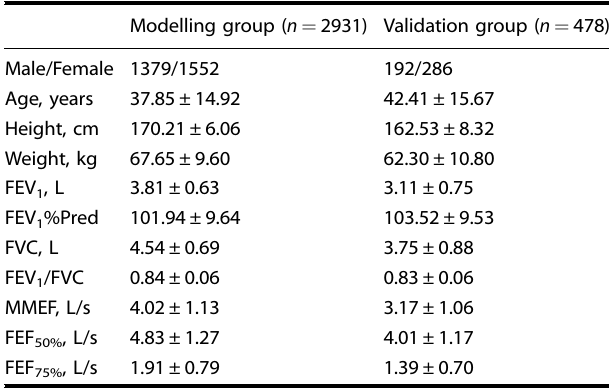
Table 1. Demographic characteristics and spirometric parameters (mean ± standard deviation) of healthy